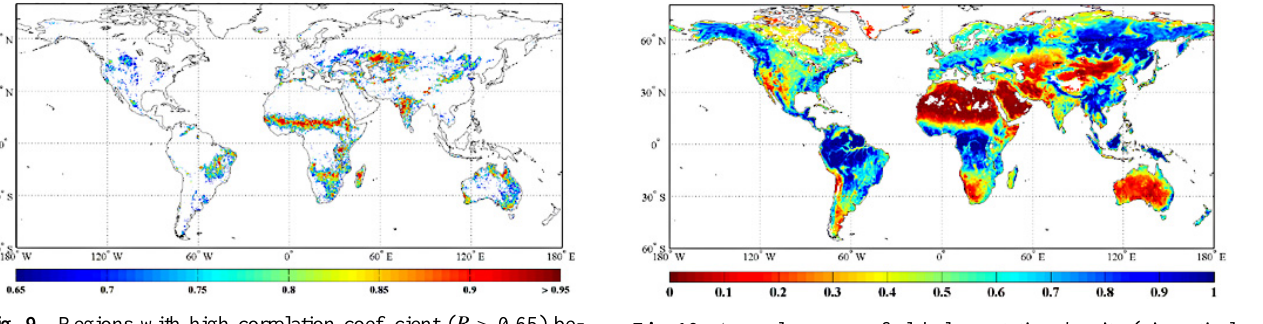
Fig. 10. Annual average of global vegetation density (via optical depth) derived from AMSR-E C-band using VUA-NASA algorithm for 2007.